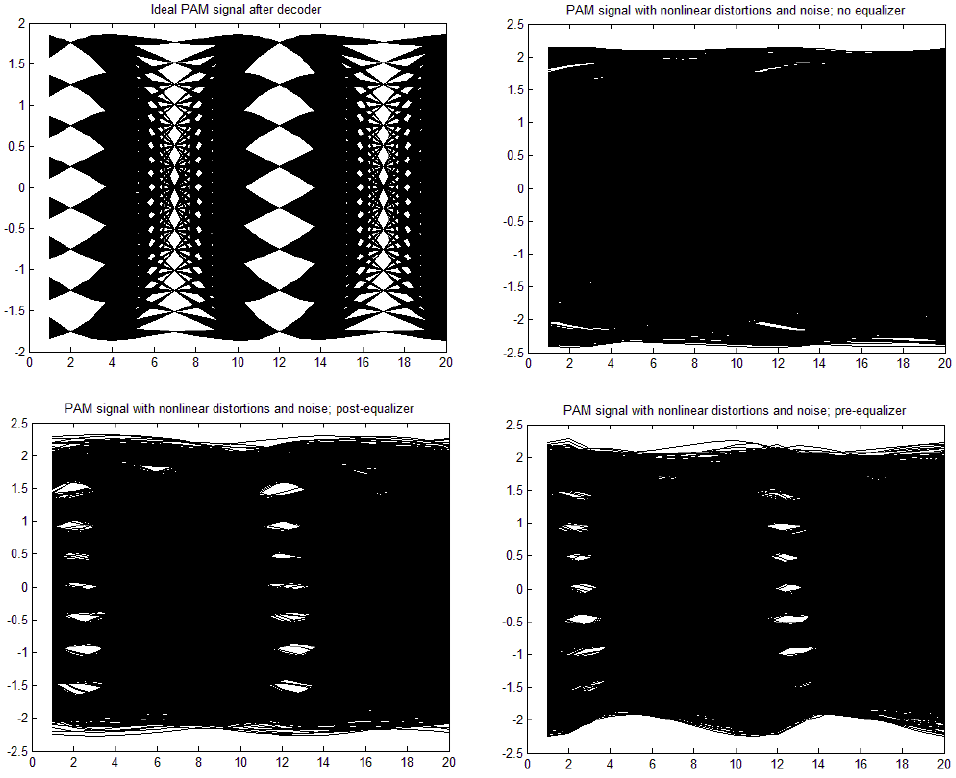
Figure 6. Eye patterns for PAM-4. Moderate nonlinearity: [1, − 0.1, 0.05, 0.02], and α = 1, SNR = 20 dB, and τ = 0.3T.